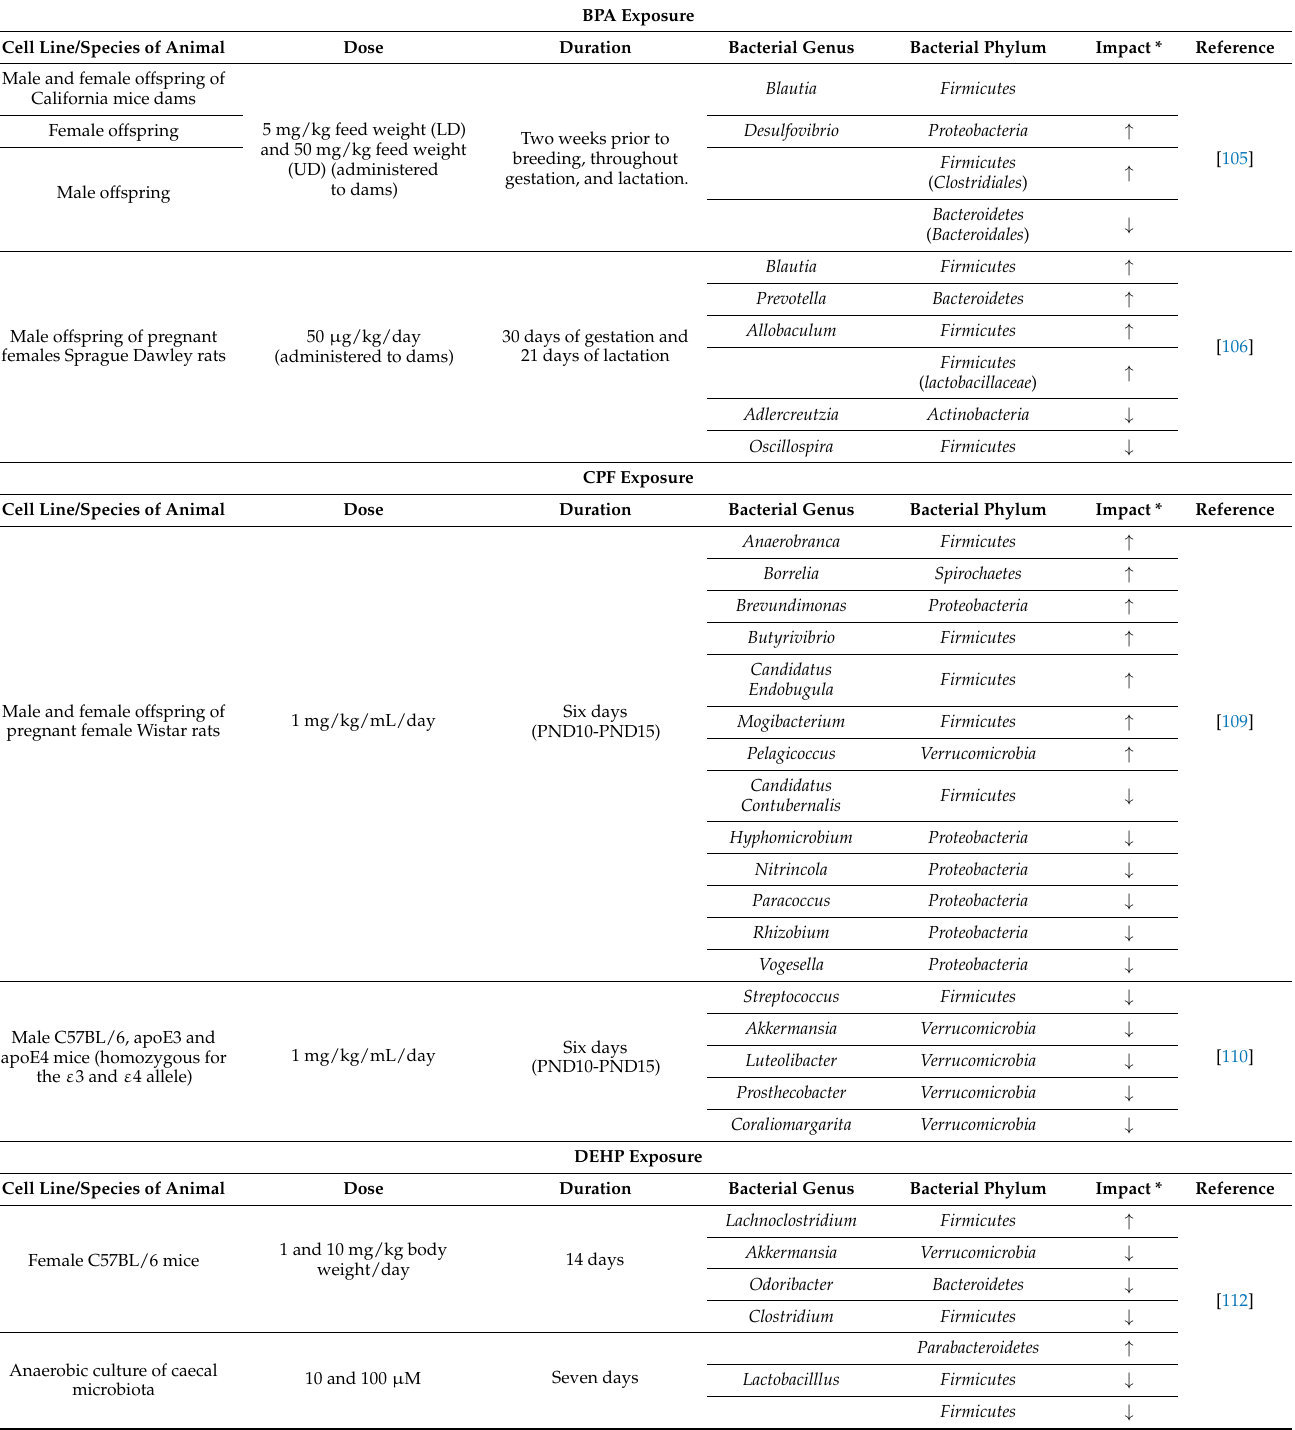
Table 5. Studies on early exposure to BPA, CPF, DEHP, and PFAS and their association with the intestinal